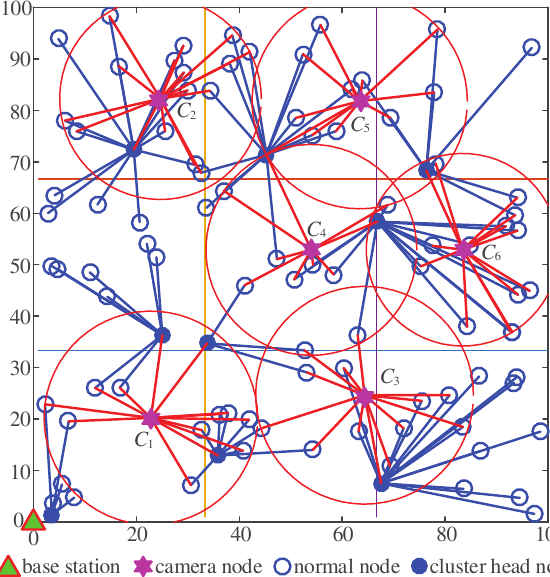
Figure 6. Distribution of the camera